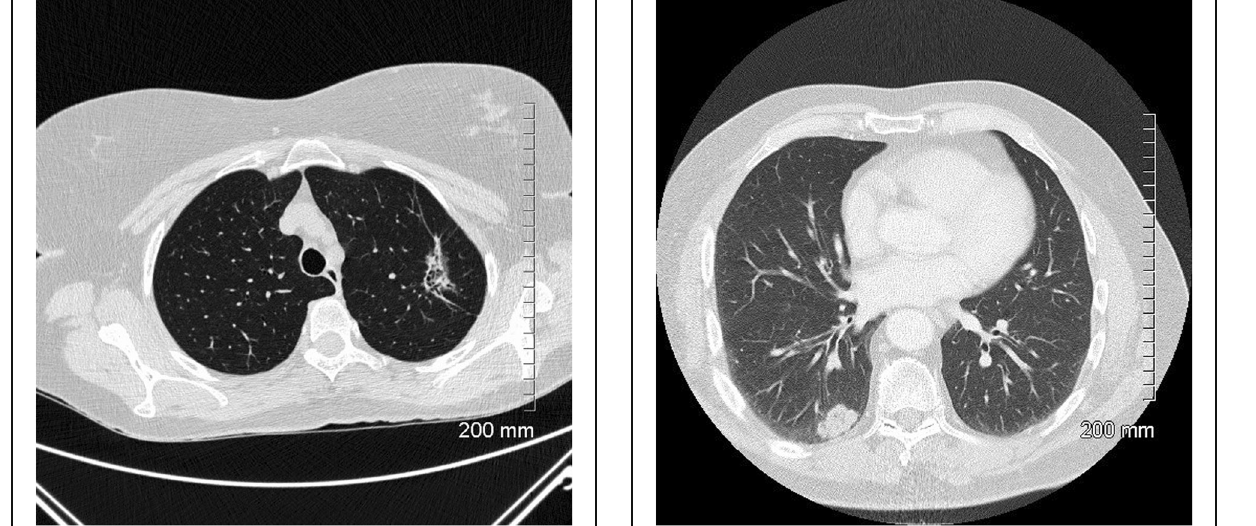
Fig. 15 Unfavourable prognostic indicators: coarse, thick spiculations. The area of mass-like consolidation in the left upper lobe also demonstrates cystic lucencies and air bronchograms. Lepidic predominant adenocarcinoma